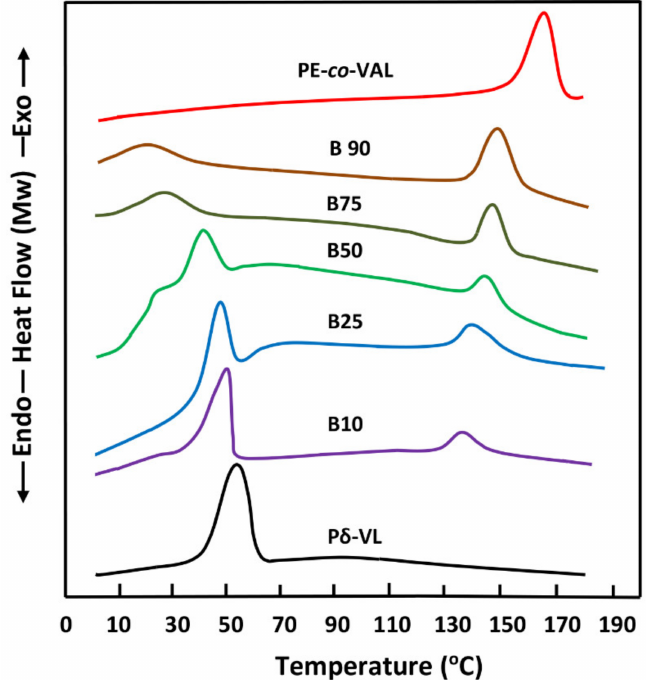
Figure 4. The DSC thermograms of blends and their pure components performed in the cooling mode during the non-isothermal crystallization